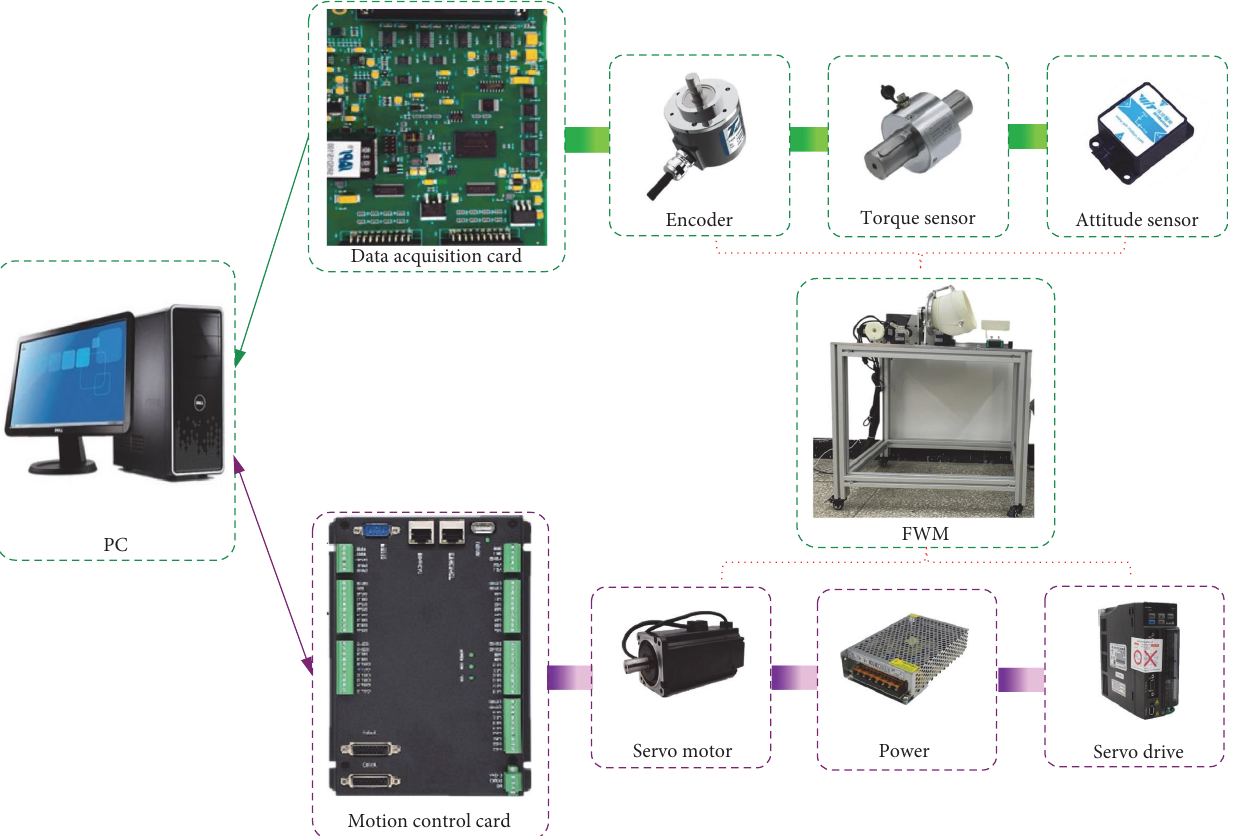
F IGURE 11: Diagram control system of